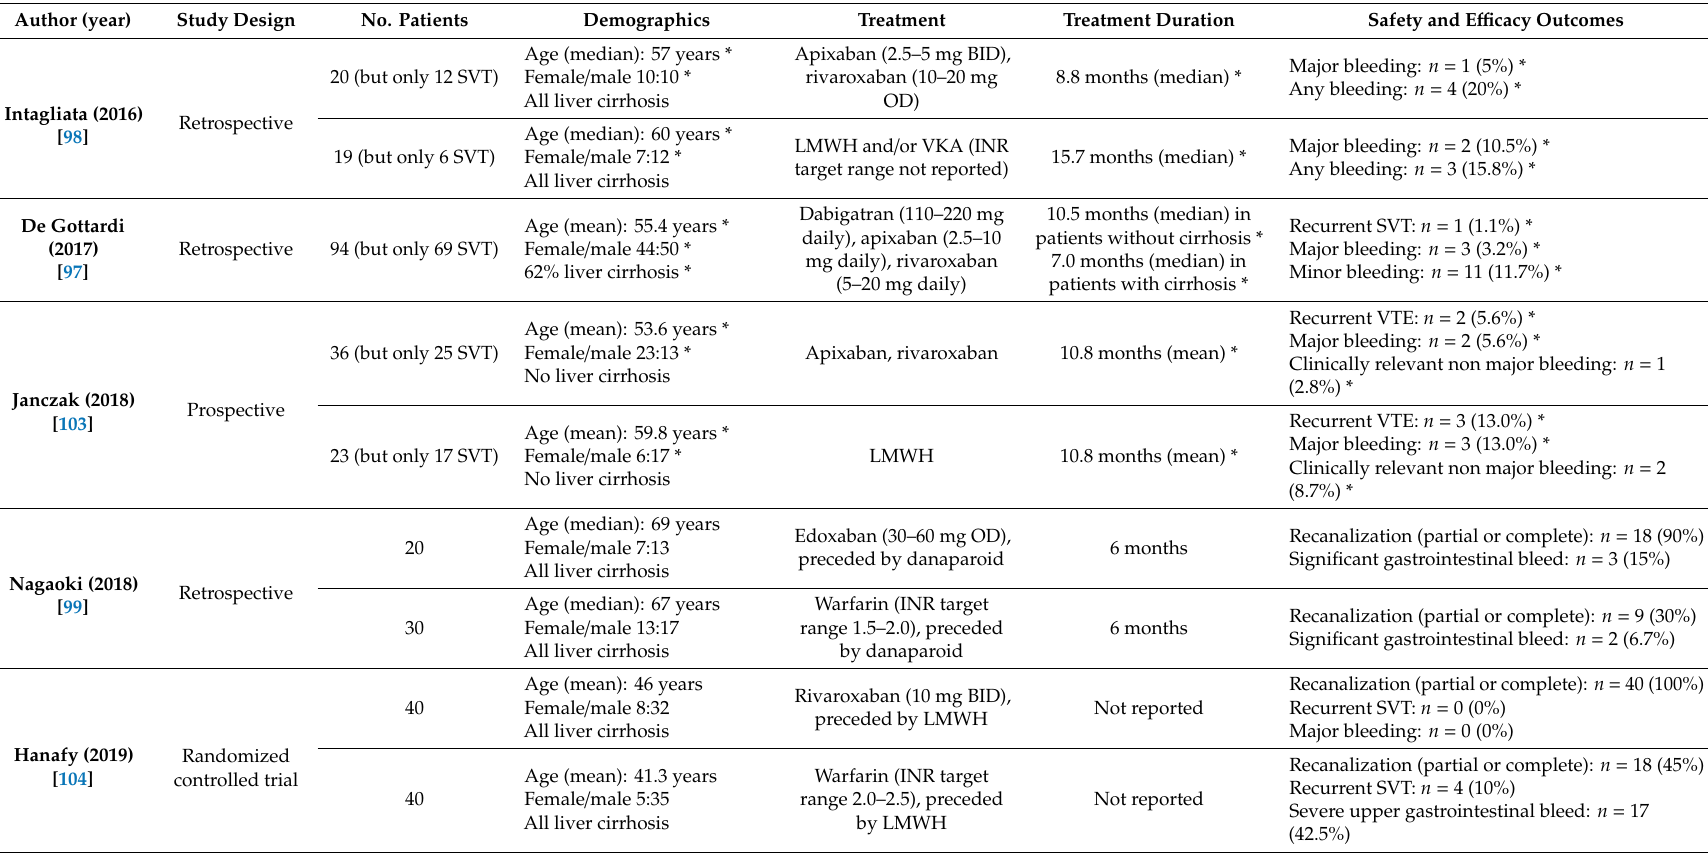
Table 2. Studies evaluating the use of the direct oral snticoagulants in patients with splanchnic vein